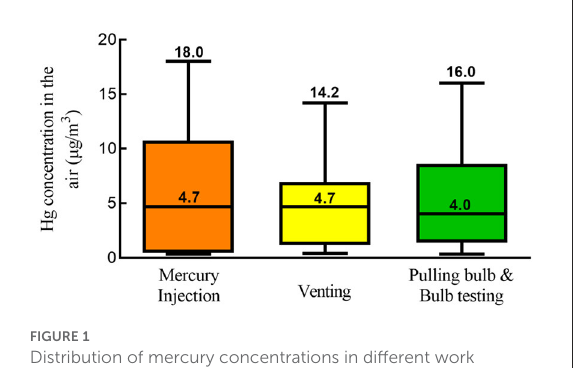
FIGURE1 Distribution of mercury concentrations in different work